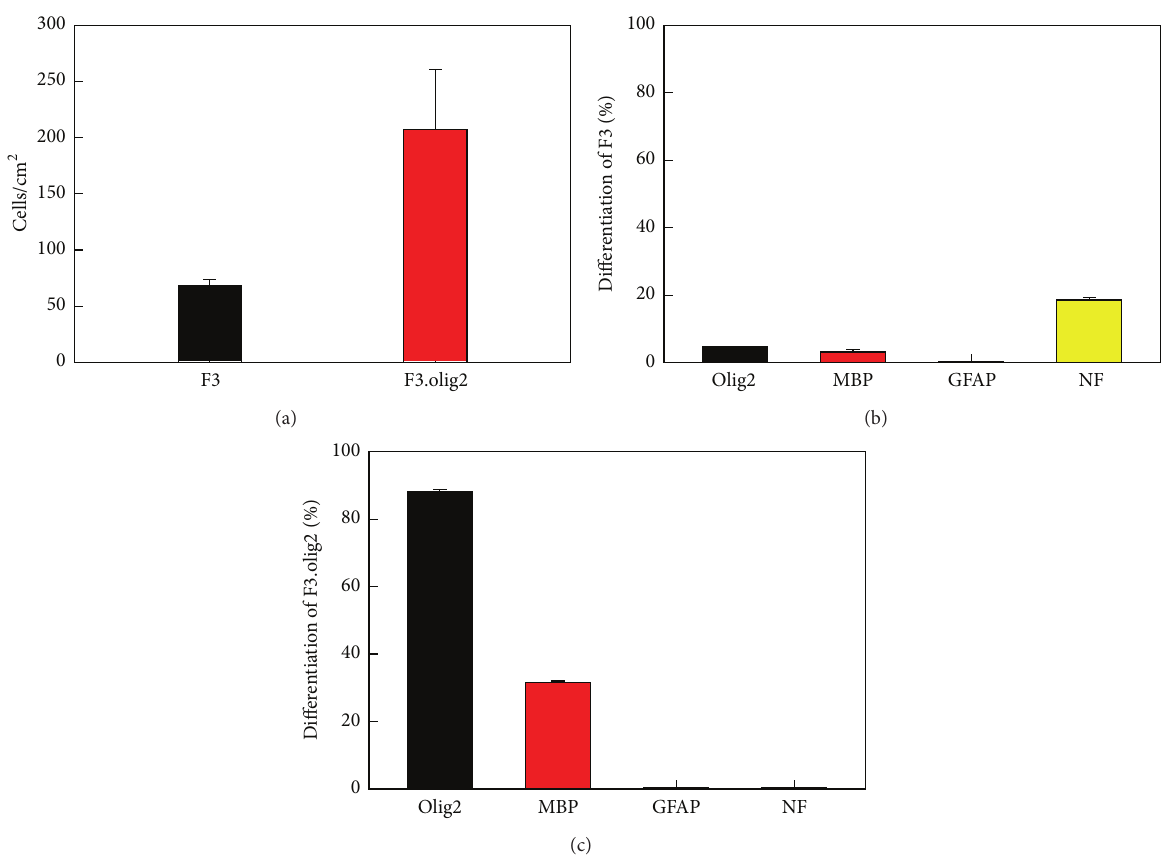
Figure 4: Numbers of transplanted human (hMito-positive) F3 and F3.olig2 cells in the thoracic spinal cords (a) and differentiation ratios of F3 (b) and F3.olig2 cells (c) in the myelin oligodendrocyte glycoprotein- (MOG-) challenged mice. Olig2: oligodendrocyte transcription factor, MBP: myelin basic proteins, GFAP: glial fibrillary acidic proteins, and NF: neurofilaments.